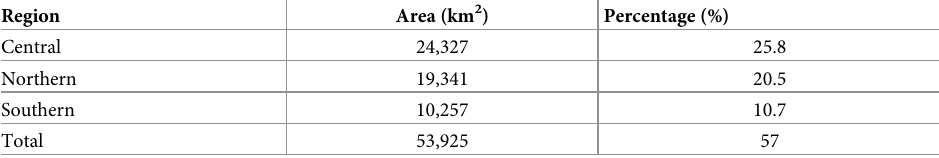
Table 3. Area and percentage suitable for growing macadamia under current climatic